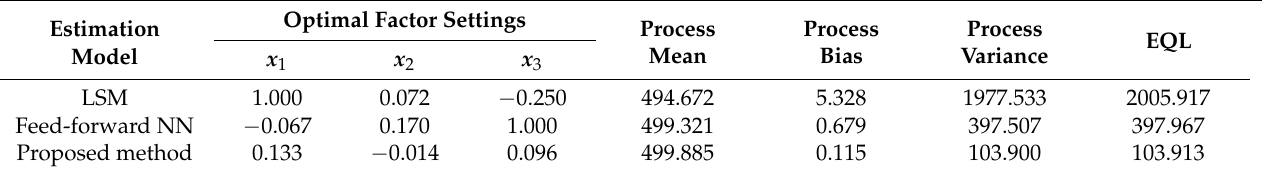
Figure 6. Estimated process mean and standard deviation response functions from the feed-forward NN approach with the proposed transfer functions: ( a ) mean ( R 2 = 67.17%); ( b ) standard deviation ( R 2 = 53.49%). Table 5. Comparative results of various methods.